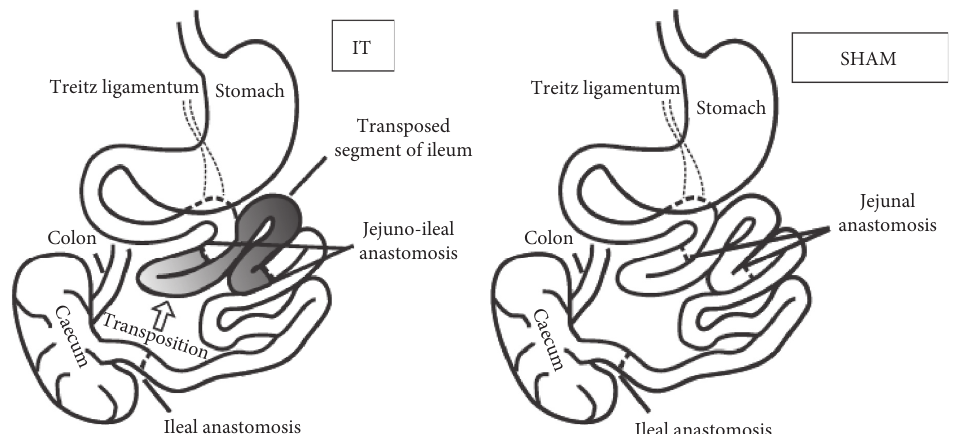
Figure 3: Schematic illustration of IT and SHAM surgery